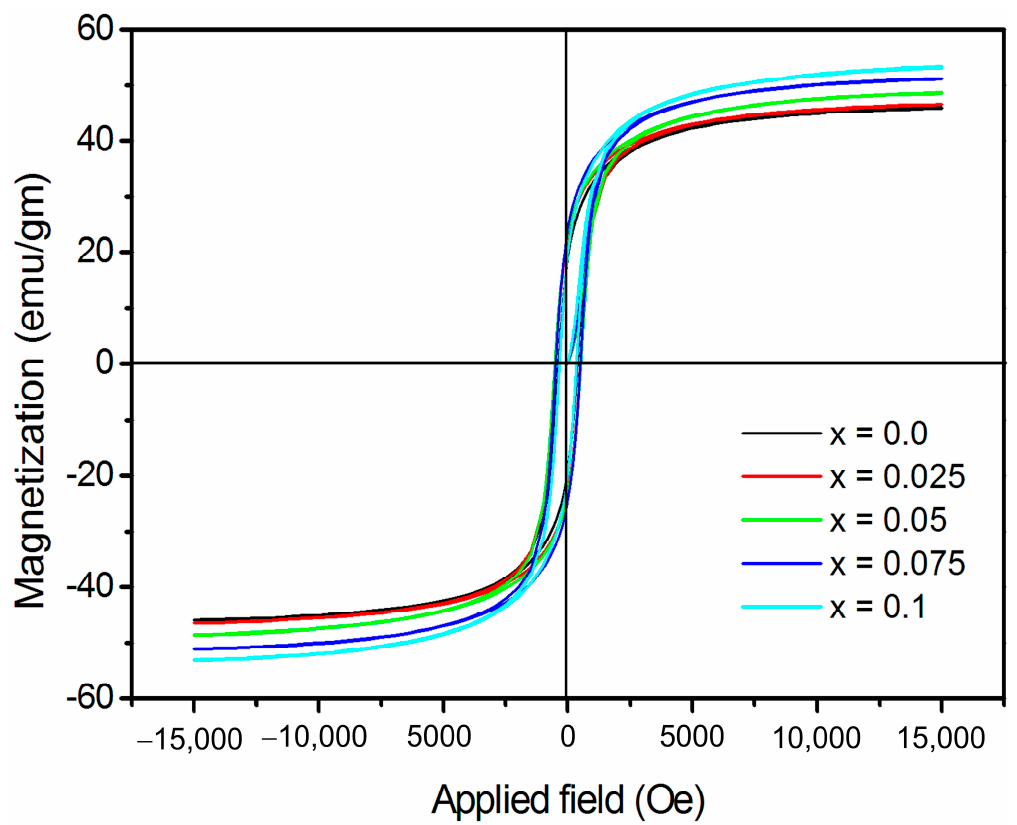
Figure 10. M-H hysteresis loops of CoCr 0.5 Dy x Fe 1.5-x O 4 . Table 6. Magnetic properties of CoCr 0.5 Dy x Fe 1.5-x O 4 . Figures in the square bracket refers to the esti- mated error.